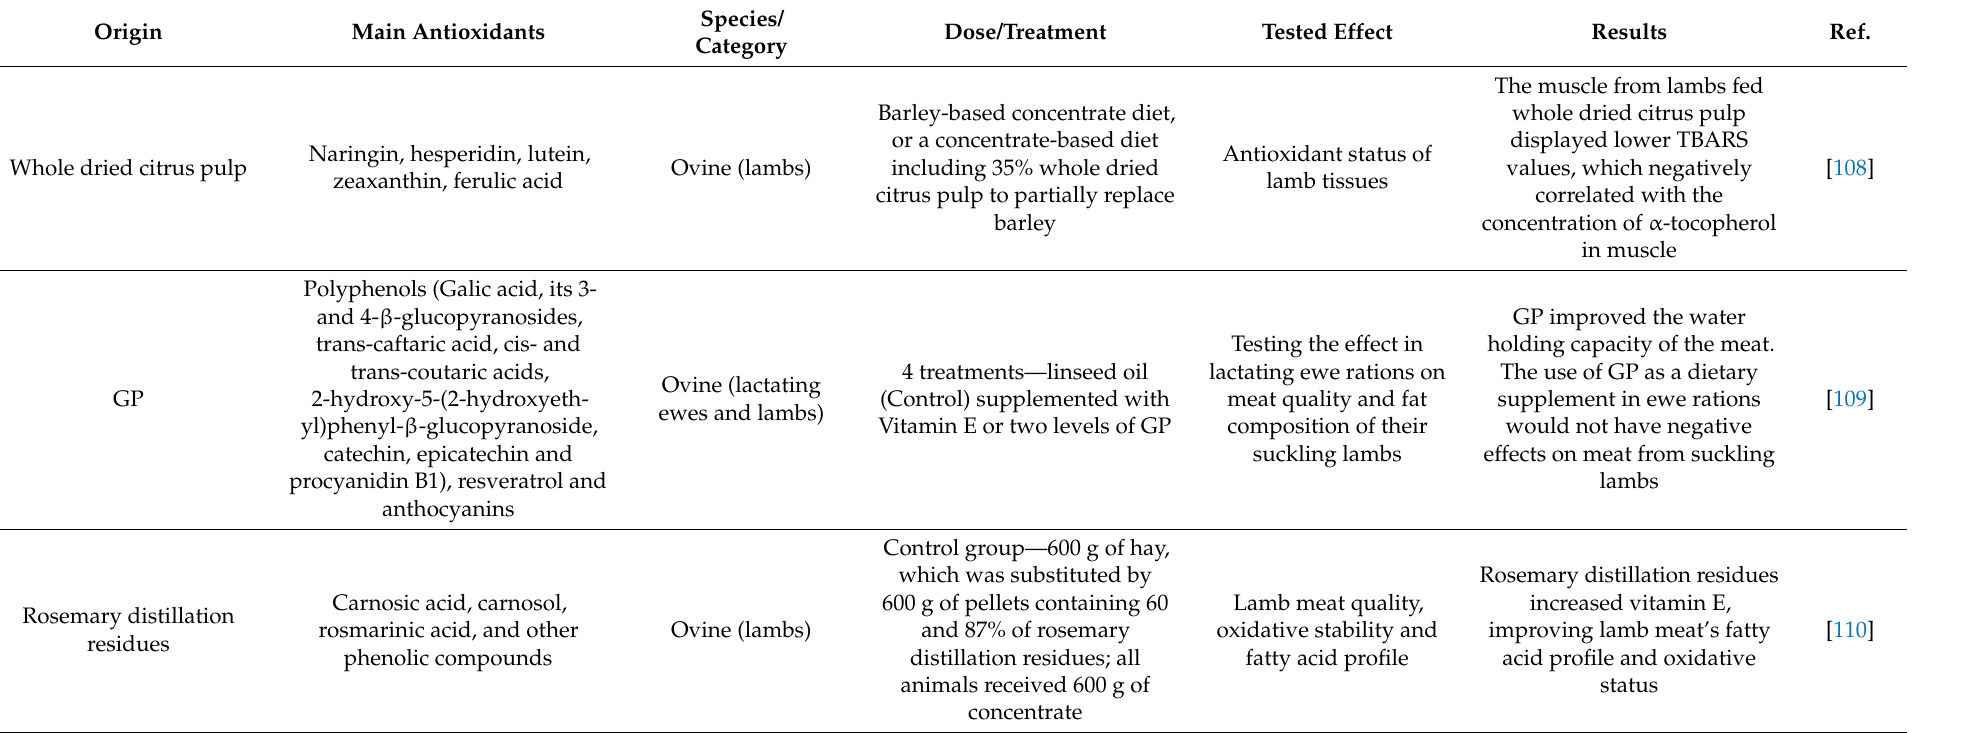
Table 4. Literature review on the effects of some natural antioxidant sources by diet supplementation in